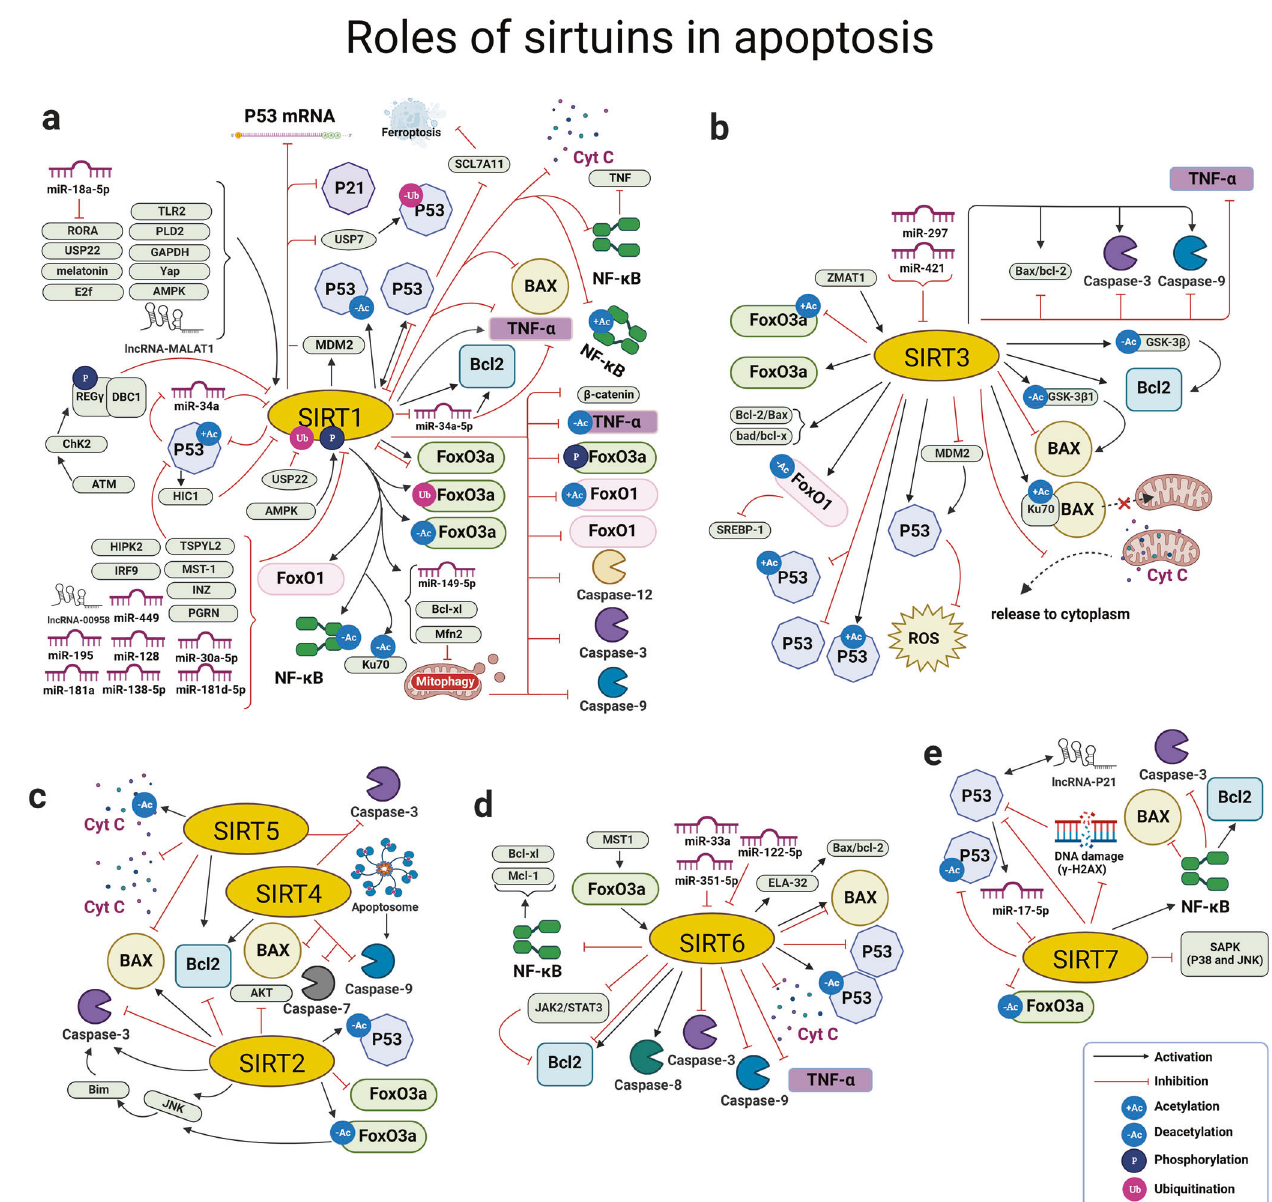
Fig. 5 Overview of the roles of SIRTs in apoptosis. SIRT protein family has functions in both physiological conditions and diseases by regulating the acetylation modi fi cation and/or in fl uencing various apoptosis-related proteins by crosstalk of pathways. Meanwhile, they can also be regulated by the molecules in the aforementioned process, such as microRNA, FoxO1, FoxO3a, TNF- α and NF- κ B. a The roles of SIRT1 in regulating apoptosis by targeting apoptosis-related proteins and pathways; ( b ) The roles of SIRT3 in regulating apoptosis by targeting apoptosis-related proteins and pathways; ( c ) The roles of SIRT2, SIRT4 and SIRT5 in regulating apoptosis by targeting apoptosis-related proteins and pathways; ( d ) The roles of SIRT6 in regulating apoptosis by targeting apoptosis-related proteins and pathways; ( e ) The roles of SIRT7 in regulating apoptosis by targeting apoptosis-related proteins and pathways. https://biorender.com. ATM ataxia telangiectasia mutated, Cyt C cytochrome c, ELA elabela, GAPDH glyceraldehyde 3-phosphate dehydrogenase, HIC1 hypermethylated in cancer-1, HIPK2 homeodomain-interacting protein kinase-2, INZ inauhzin, JAK2 janus kinase 2, MALAT1 metastasis-associated lung adenocarcinoma transcript 1, Mcl-1 myeloid cell leukemia 1, MicRNA microRNA, MST1 mammalian sterile 20-like kinase 1, PLD2 phospholipase D2, RORA retinoid-related orphan receptor α , TSPYL2 testis-speci fi c protein y-encoded-like 2, Yap yes-associated protein, ZMAT1 zinc fi nger matrin-type